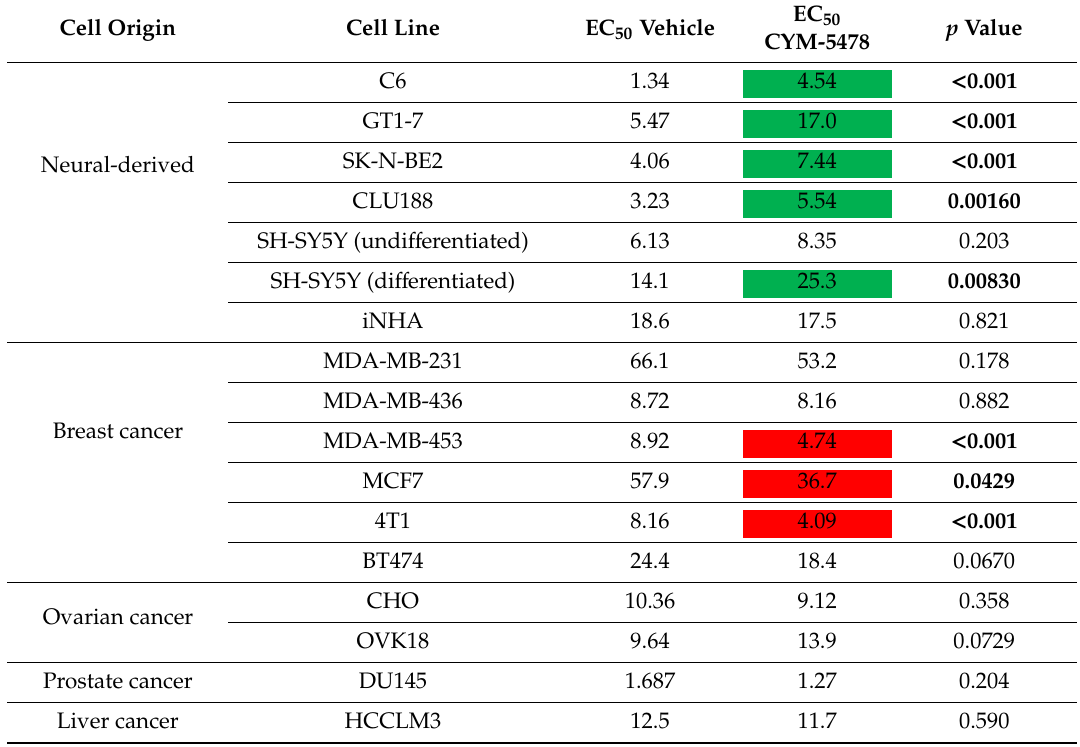
Table 1. Sensitivity of cell lines to cisplatin in the presence of vehicle or 20 µ M CYM-5478. Green indicates a significant decrease in sensitivity. Red indicates a significant increase in sensitivity. Values in bold indicate statistical significance ( p <